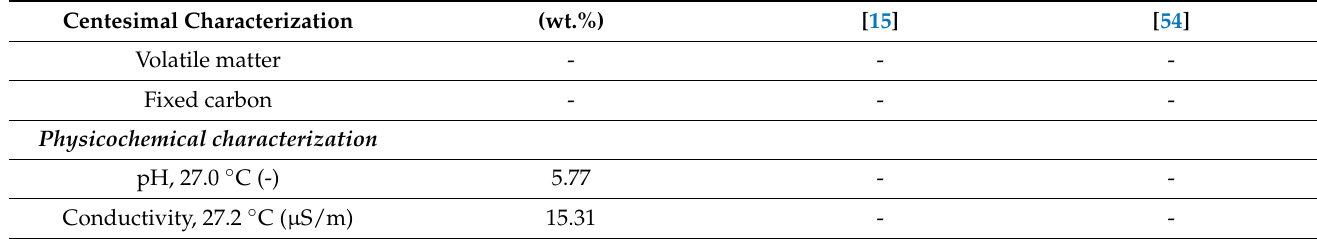
Figure 8. SEM of bio-char obtained by thermal catalytic cracking of ( organic matter + paper) frac- tion of MHSW at 475 °C, 1.0 atmosphere, with 15.0% (wt.) Ca(OH) 2 [MAG: 3000× ( a ); MAG: 6000× ( b ); MAG: 12,000× ( c )]. The microscopies, with the pre-treatment of metallization, of bio-char obtained by pyrolysis of (organic matter + paper) fraction of MHSW at 450 °C, 1.0 atmosphere, and by catalytic cracking of (organic matter + paper) fraction of MHSW at 475 °C, 1.0 atmosphere, with 10.0% (wt.) Ca(OH) 2 , in laboratory scale, illustrated in Figure 9. The SEM images of bio-char by pyrolysis of (organic matter + paper) fraction of MHSW at 450 °C, 1.0 atmos- phere, illustrated in Figure 9a, show the formation of a porous structure similar to a bee- hive, proving that pyrolysis has drastically changed the morphological structure of (or- ganic matter + paper) fraction of MHSW. In addition, the appearance of granules has not been seen. On the other hand, the SEM images of bio-char by catalytic cracking of (organic matter + paper) fraction of MHSW at 475 °C, 1.0 atmosphere, with 10.0% (wt.) Ca(OH) 2 , shows the formation of cavities over the carbonized structure of bio-char, as well as the appearance of granules (white) on the carbonized structure of bio-char. This is likely due to the Ca(OH) 2 being used as catalysts. The granules (white colored) of different sizes scattered over the surface are similar to SEM images of CaCO 3 (calcite) reported by Cabrera-Penna et al. [55], as well as the SEM images of Ca(OH) 2 reported by Hassani et al. [56], and SEM images of bio-char obtained by pyrolysis of MSW reported by Gopu et al. [57].